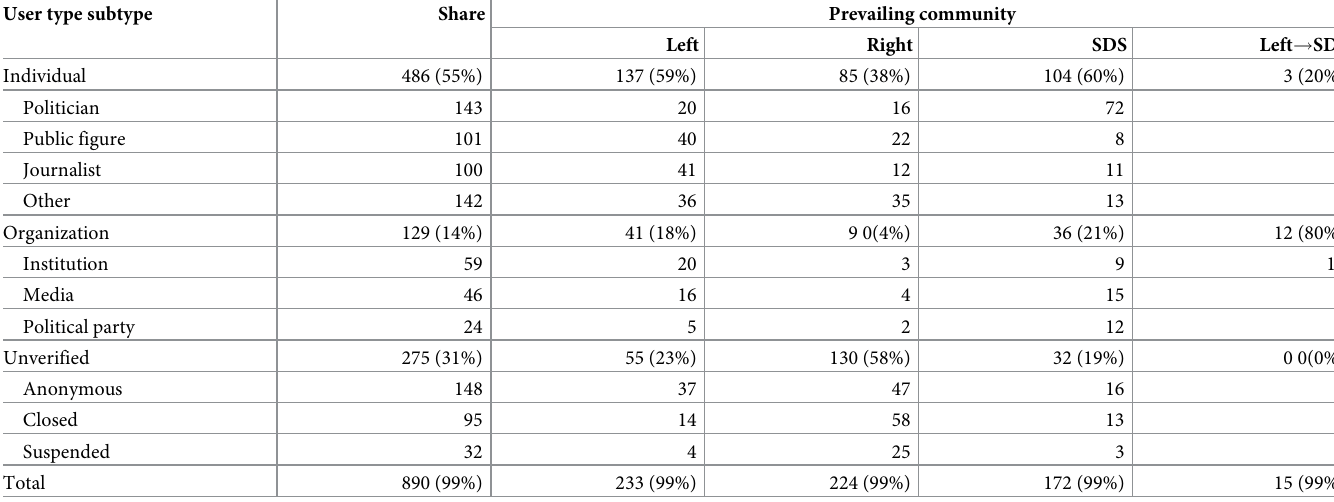
Table 8. Twitter user types and their prevailing communities. The top 890 users from the major communities, ranked by the retweet h-index, are classified into different types. When possible (in over 72% of the cases) the prevailing community across the five timepoints is determined. The rest of the users shift between different communi- ties through time. There is an interesting transition community Left ! SDS that corresponds to the government transition from the left-wing to the right-wing, and consists mostly of the governmental institutions.